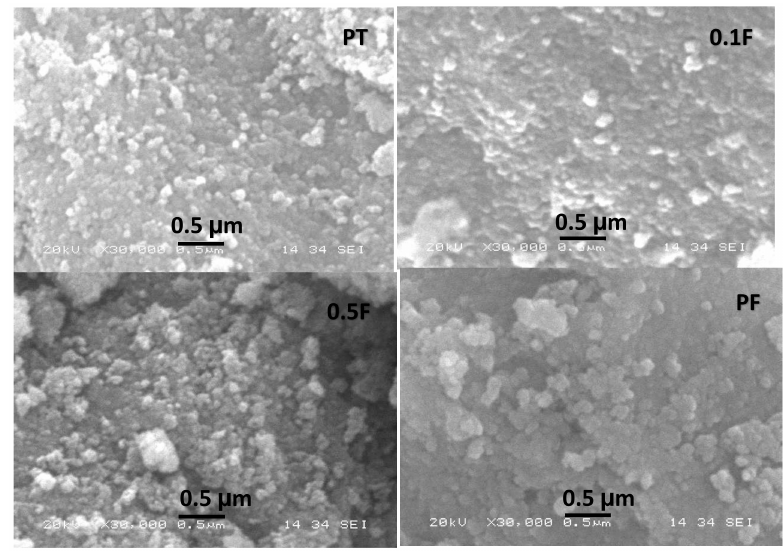
Figure 2. SEM images of (TiO 2 ) 1 − x (Fe 2 O 3 ) x